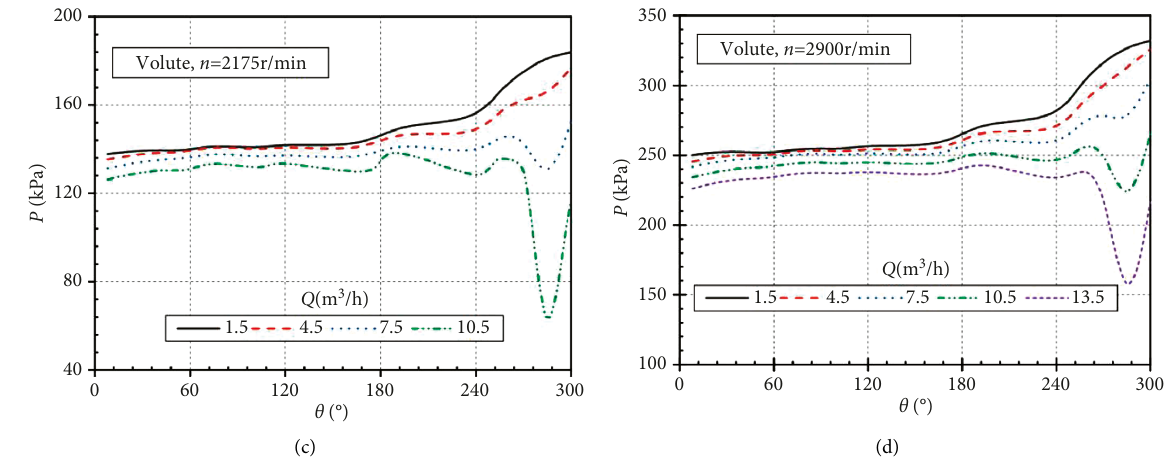
Figure 13: Circumferential average static pressure distribution at the middle section of volute.